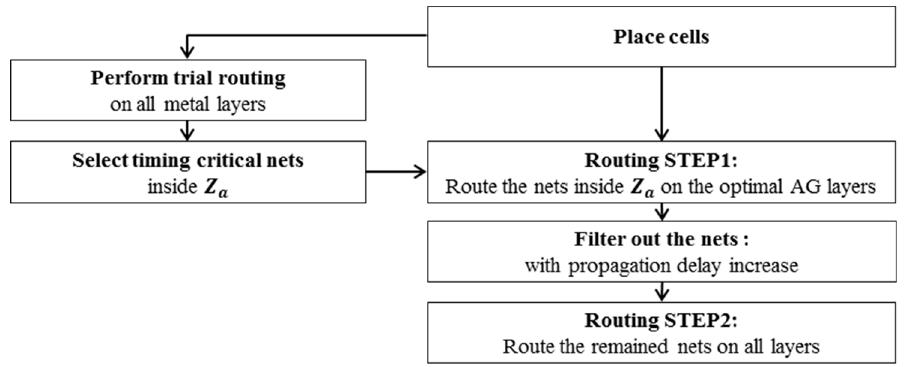
Figure 5. AG-aware implementation flow with two-step routing.